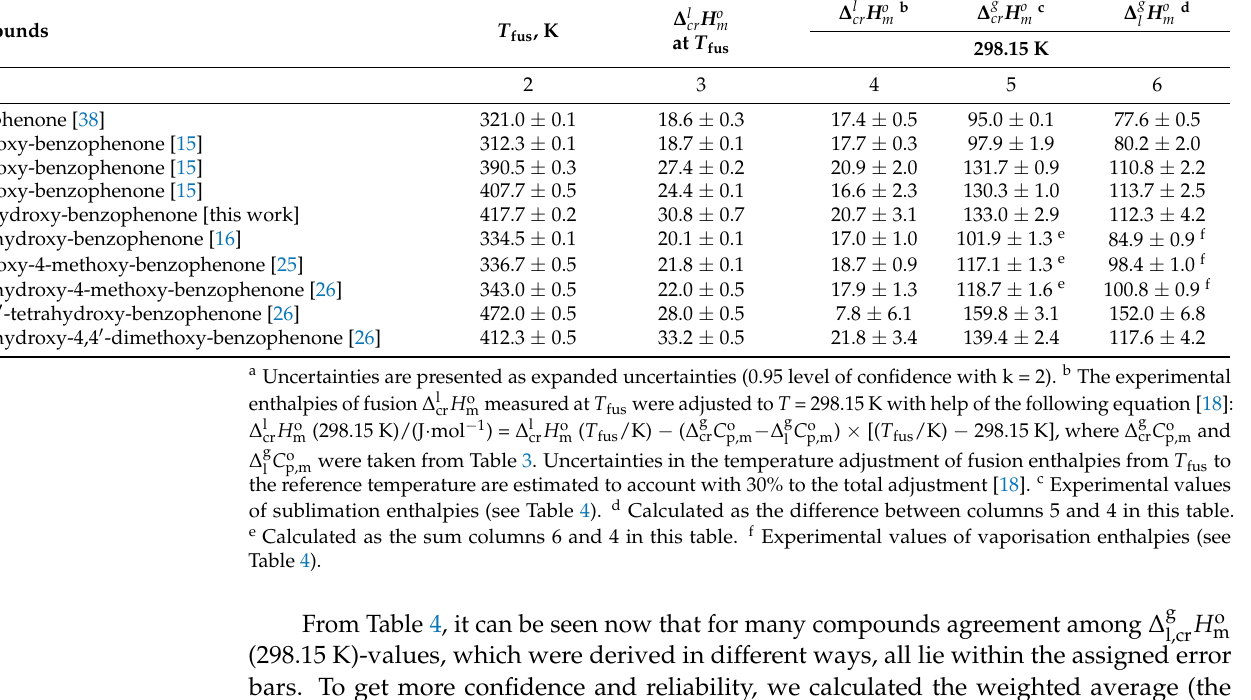
Table 7. Phase transitions thermodynamics of substituted benzophenones (in kJ · mol − 1 ) a . Compounds T fus ,